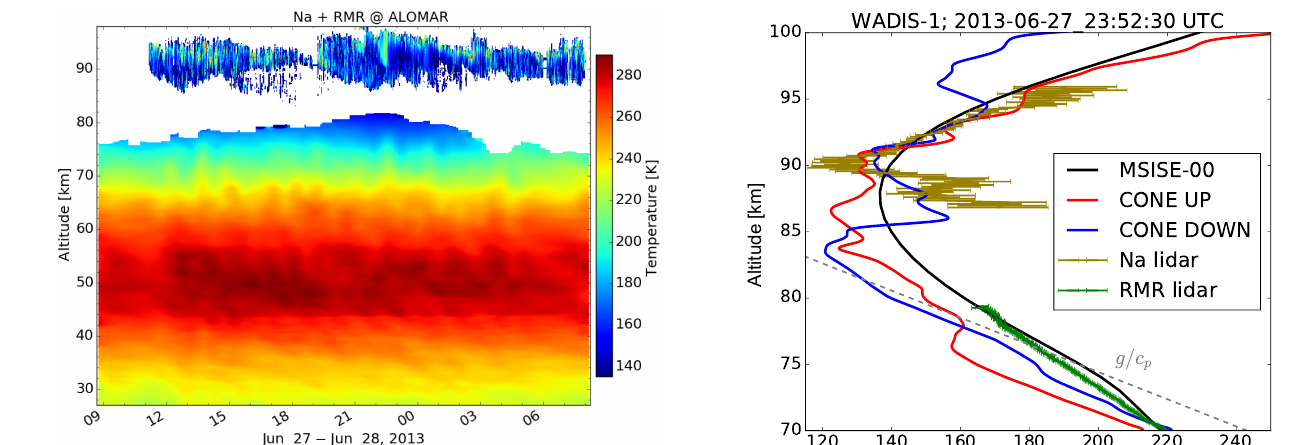
Figure 10. Simultaneously measured temperature profiles during WADIS-1 launch. The rocket-borne measurements were done with the ionization gauge CONE. See text for